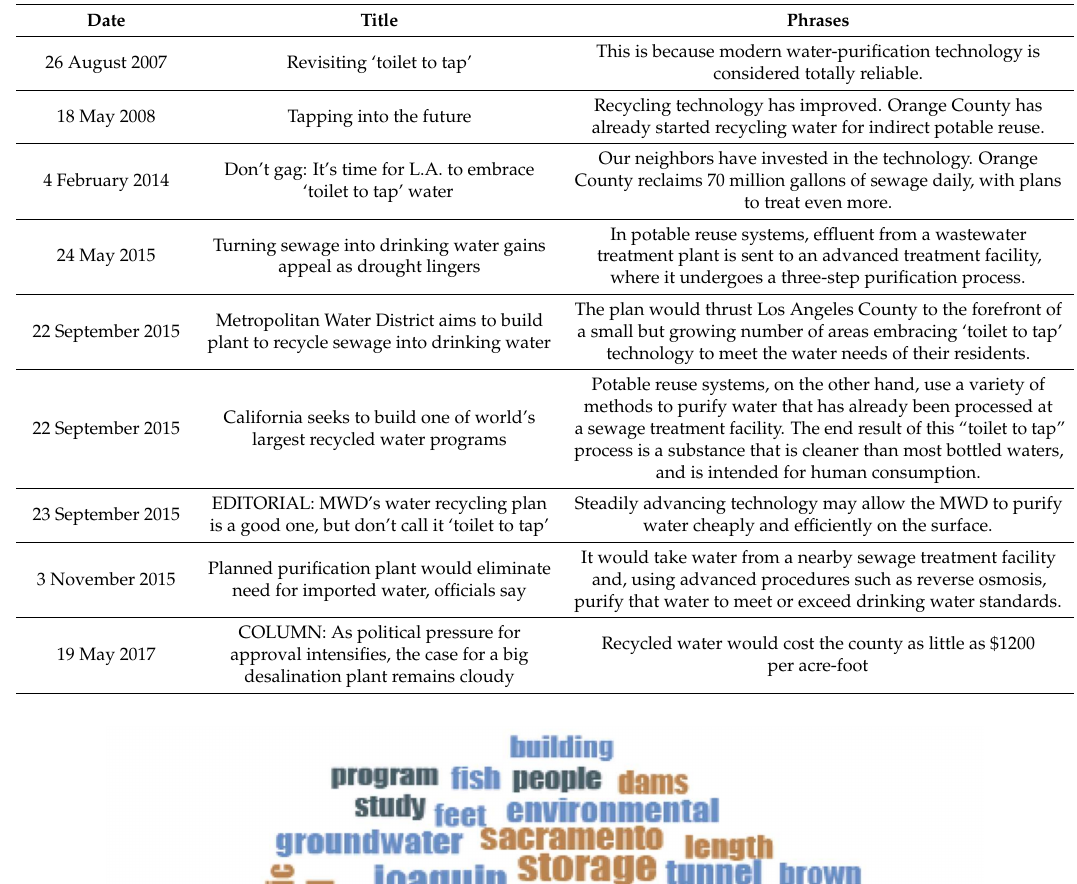
Table 2. Excerpts of selected newspaper articles in the Los Angeles Times.